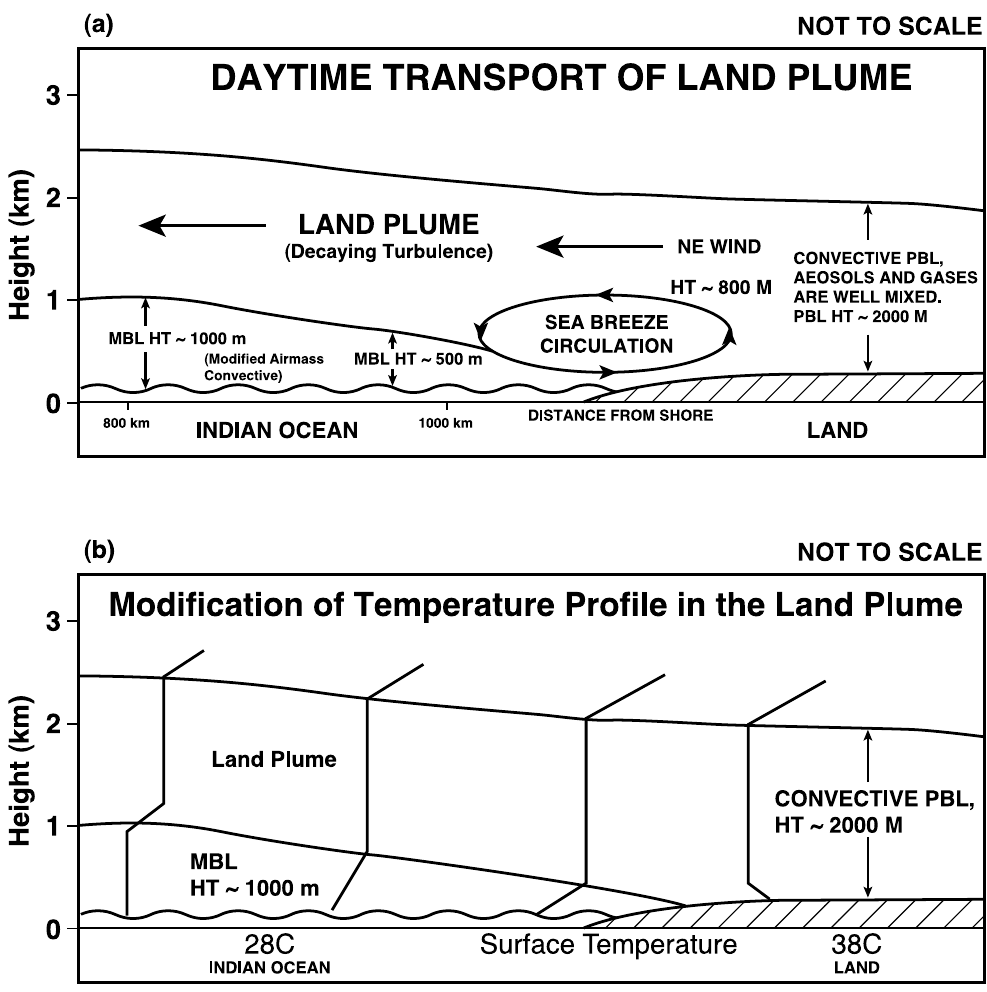
Fig. 16. Conceptual depiction of the interaction between the coastal sea breeze circulation and the land plume over the Indian Ocean during day (redrawn from Simpson and Raman, 2004, copyright 2004 by the Springer Verlag, reproduced with permission).